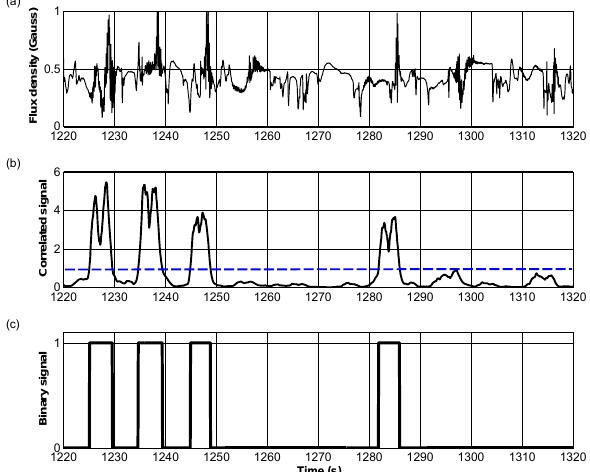
Figure 10. Circulation time distribution of all four sensor particles (SP1 ... 4) in the biogas digester at the impeller speeds (a) 5.5 and (b) 6.7ms − 1 . The distribution of the combined time series of all sensor particles is given in